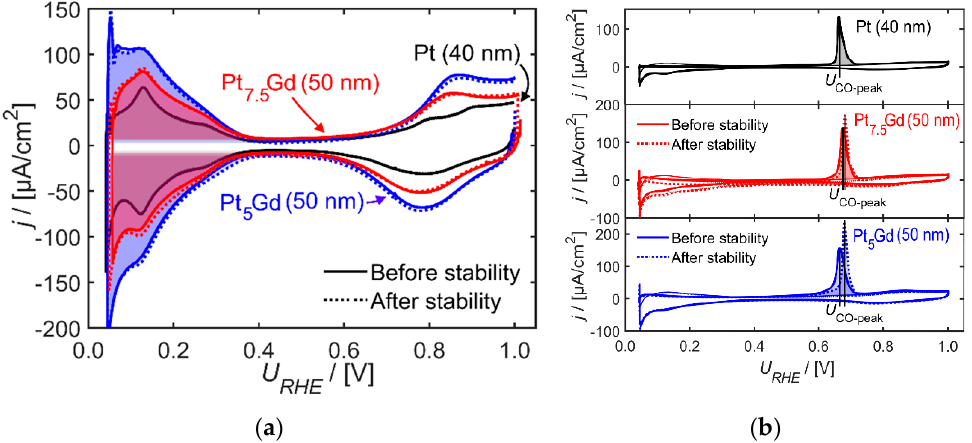
Figure 4. Electrochemical characterization and electrochemically active surface area (ECSA) determination of pure 40-nm Pt, 50-nm-thick Pt 5 Gd (blue) and Pt 7.5 Gd (red) thin films in 0.1-M HClO 4 electrolyte at room temperature before (full lines) and after stability (dashed lines) tests; ( a ) base CVs in N 2 -saturated electrolyte at 50 mV/s and 400 rpm, with H-adsorption charge area sketched; ( b ) CO-striping peaks of Pt (top) Pt 7.5 Gd (center) and Pt 5 Gd (bottom) at 10 mV/s in N 2 -satuated electrolyte and 200 rpm, with CO-stripping charge area sketched. Potential of the maxima of the CO oxidation peaks is included. All current densities normalized to the geometric electrode area of ~0.196 cm 2 .